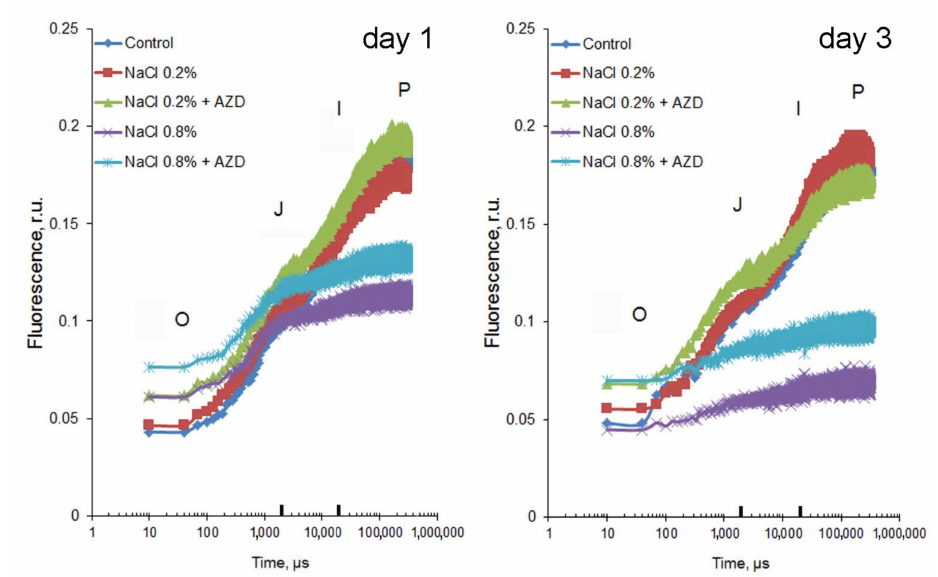
Figure 3. Effects of salinity and/or addition of AZD8055 (0.2 µ M) on the fluorescence induction parameters (OJIP curves) in Haematococcus lacustris cells exposed for 1 or 3 days to different levels of NaCl (0.2% or 0.8%, respectively) either in the presence or absence of AZD8055 (AZD). Each curve represents the average of 10–24 replicates. Black marks on the X-axis correspond to 2 ms (‘J’-step) and 20 ms (‘I’-step),